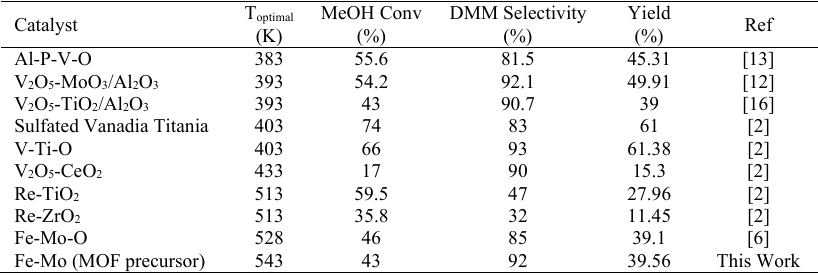
Fig. 6: Influence of reaction temperature on methanol conversion Fig. 7: Influence of GHSV on methanol conversion over Fe- over Fe-MoI ( ), Fe-MoII ( ) and Fe-MoIII ( ) catalysts. MoI ( ), Fe-MoII ( ) and Fe-MoIII ( ) catalysts. Experimental Experimental conditions: GHSV = 16 NLh −1 g −1 , CH OH/O /N 3 2 2 = 40/13/47 mol%. Table 2. Comparison of catalyst activities between previous studies and the current